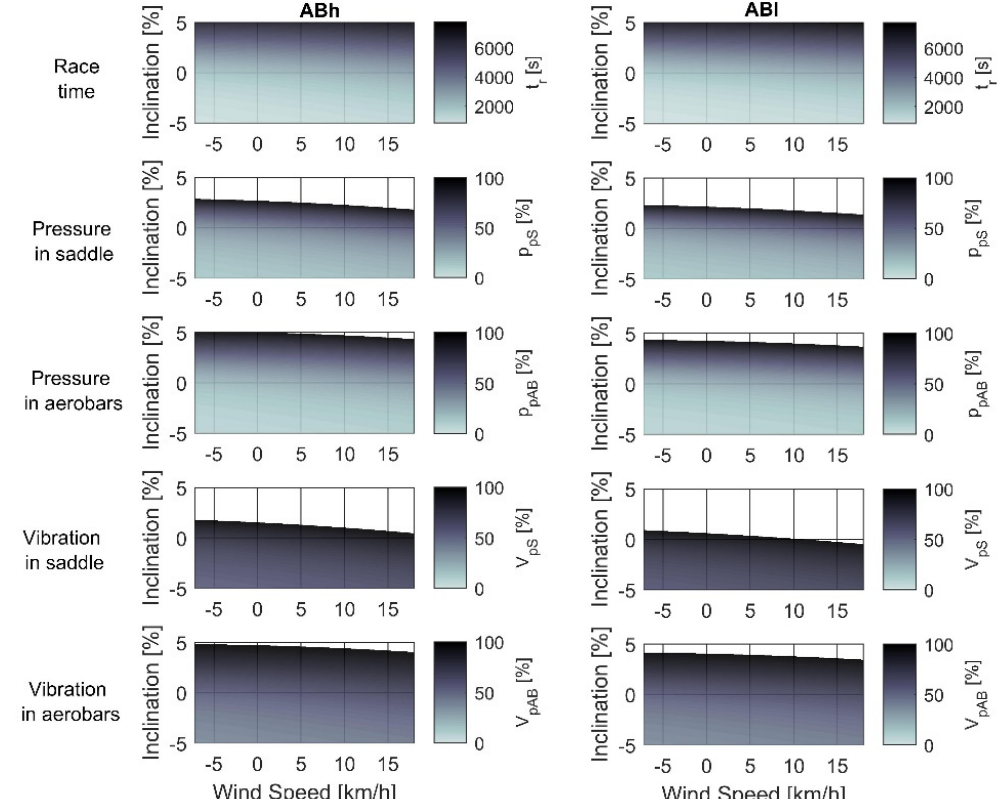
Figure 6. Detailed results obtained for the posture selection of rider 1.